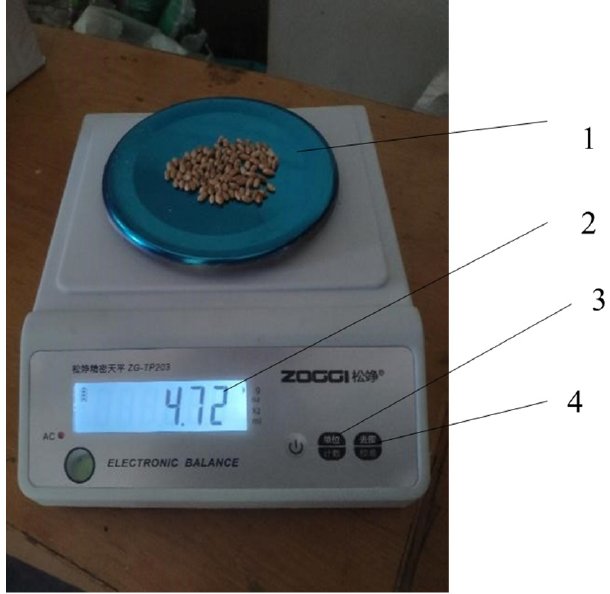
Figure 6. Thousand seed weight measurement by the 100-seeds method. 1. Wheat seed. 2. Display interface. 3. Counting unit. 4. Scaling unit.